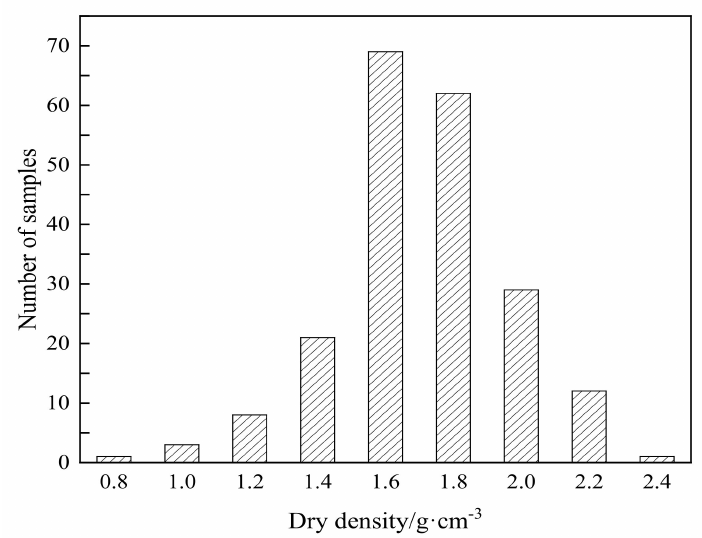
Figure 3. Dry density distribution of tested sandy